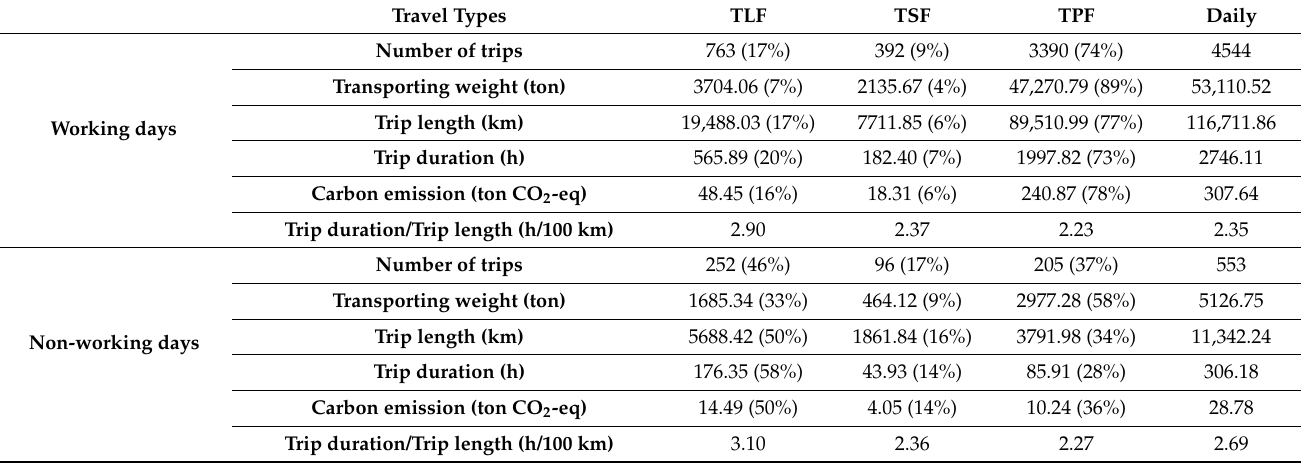
Table 8. Daily freight performance and carbon